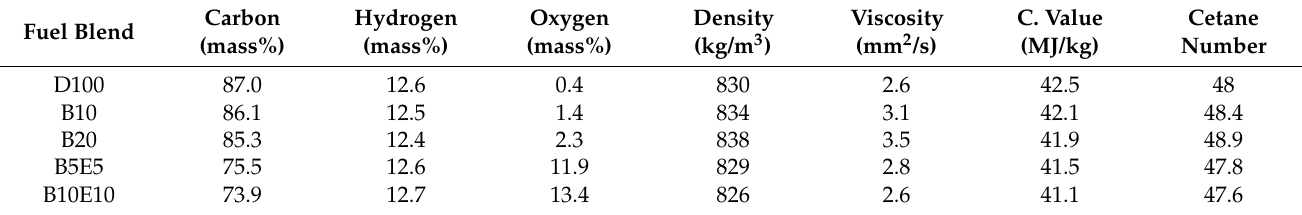
Table 2. Physicochemical properties of diesel, binary and ternary test